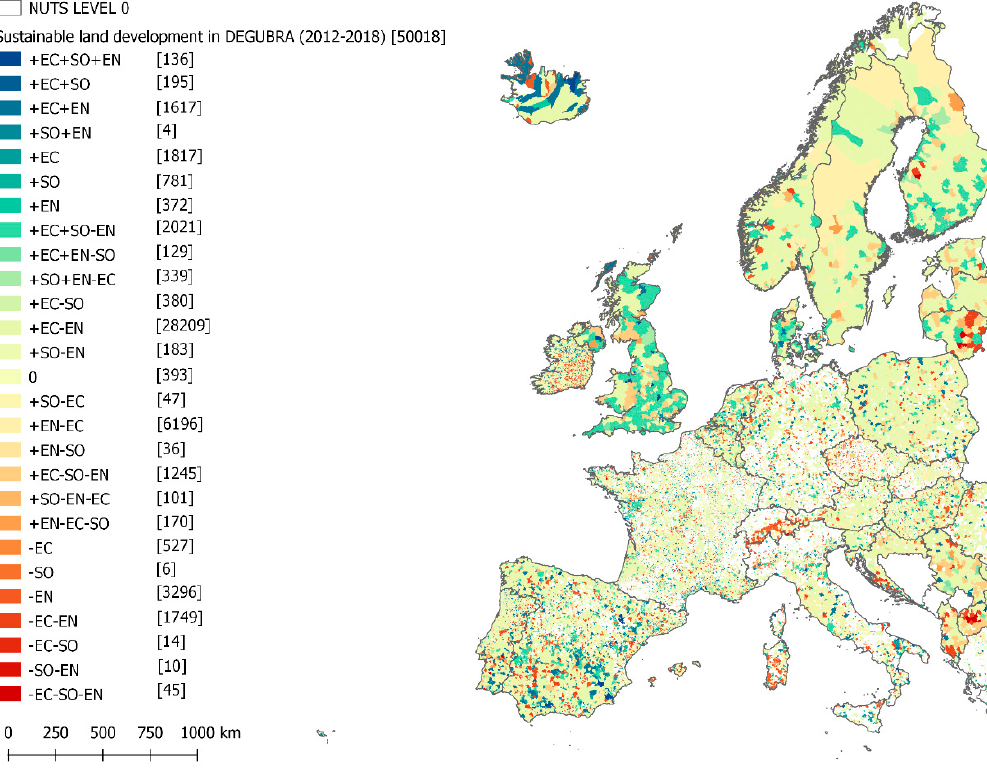
Figure 2. Sustainability assessment of local change directions.